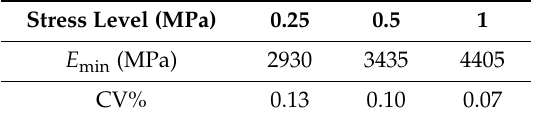
Table 8. The critical value of dynamic modulus ( E min ) of fatigue test.